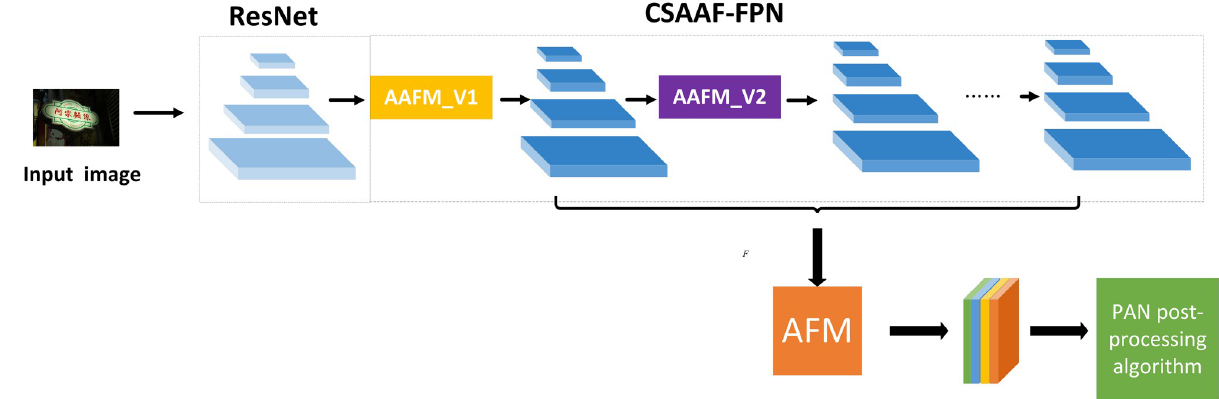
Fig 1. Overall architecture of AAF-Net. It includes a basic structure with ResNet-18; a cross-scale attention aggregation feature pyramid network (CSAA-FPN); an adaptive fusion module (AFM); the pixel aggregation algorithm. The features from lightweight backbone network are enhanced by a segmentation head which is composed of CSAA-FPN and